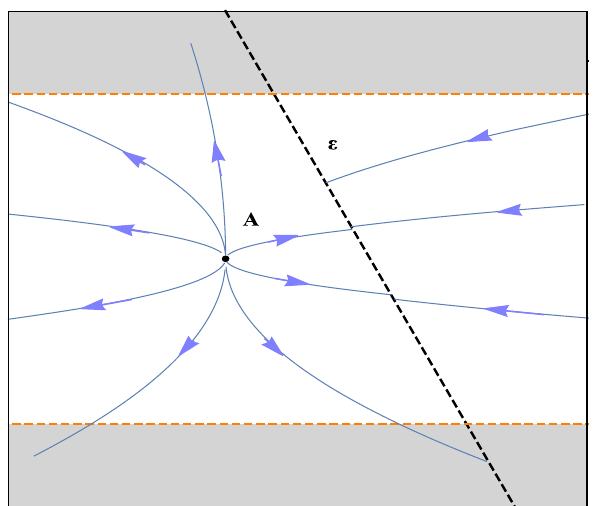
Fig. 1 Phase-space diagram around two of the equilibrium points seen in cases (i) and (ii) of Sect. 3.3. The unstable fixed point A is a torsion-free, ¯ Ω ρ = 1 Friedmann universe with radiative matter or dust (e.g. see [18], or Sect. 4.2 here). The dashed diagonal line ( ε ) represents an accelerating, Λ -dominated, FRW-like cosmology with weak torsion (i.e. | ¯ Ω φ | (cid:3) 1) and radiation (or dust), which is stable in the Lyapunoc sense. Note the shaded regions at the top and at the bottom of the dia- gram. These contain FRW-like universes with | ¯ Ω φ | > 1 and therefore lie beyond the range of this study (see Sect.